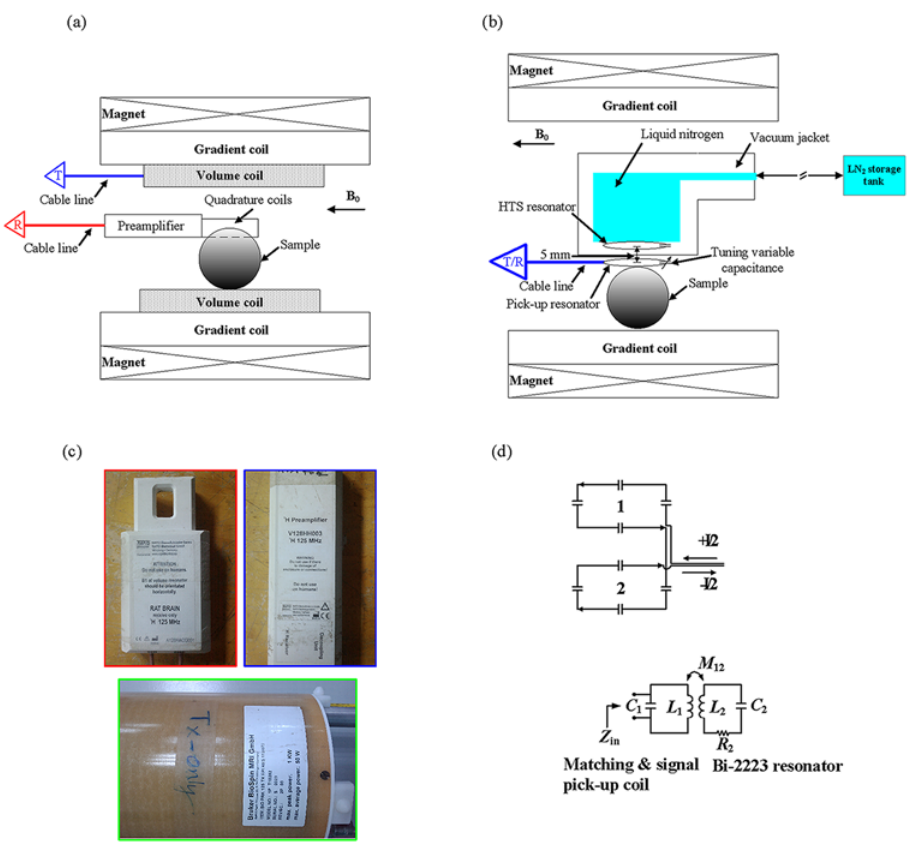
Fig 1. The experimental setup of the different coils and the details of the QD surface resonator. (a) The 3T system setup of the phantom experiment, where the QD surface resonator was put inside the QD volume resonator. (b) The 3T system setup of the phantom experiment, where the matching and signal pick-up resonator with a tuning variable capacitance was put under the cryostat and the HTS surface resonator. (c) Top left: the QD surface resonator, Top right: the preamplifier, and the bottom: the QD volume resonator. (d) The top: The geometry of QD form circuit, the bottom: the circuit diagram of the matching and signal pick-up resonator with the variable tuning trimmer capacitor C 1 and the Bi-2223 surface resonator.